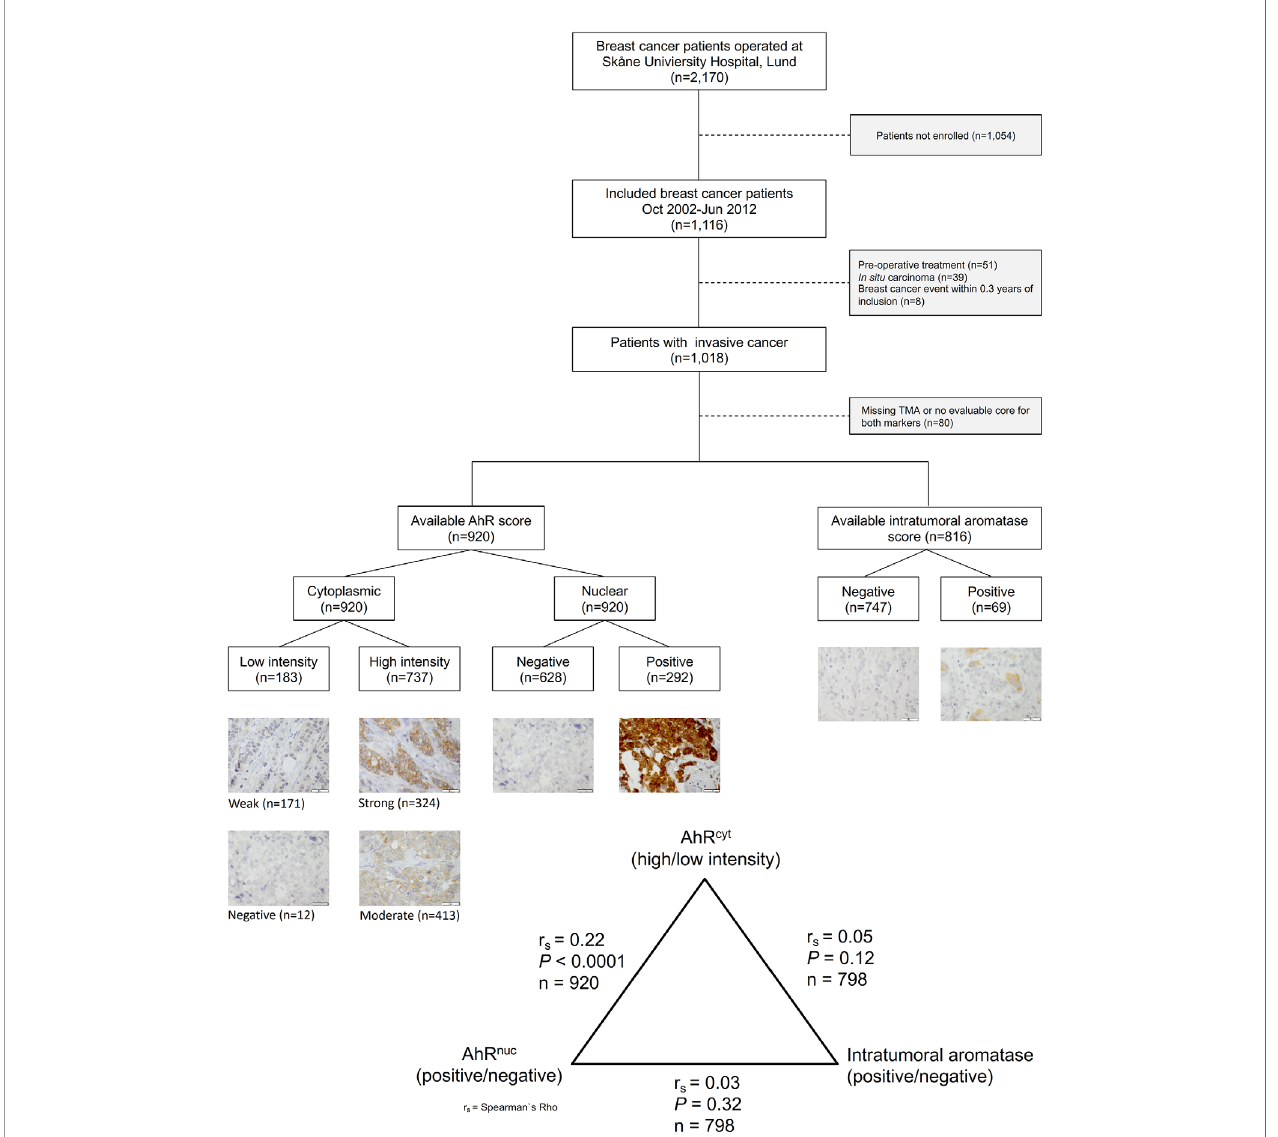
FIGURE 1 | Inclusion fl owchart showing the number of included and excluded patients and representative images of AhR and aromatase staining intensities (40×). The bar represents 20